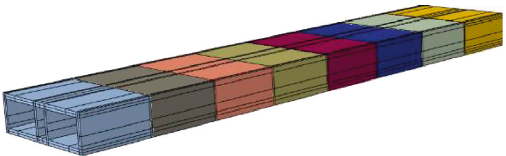
Figure 13: Finite element analysis model.